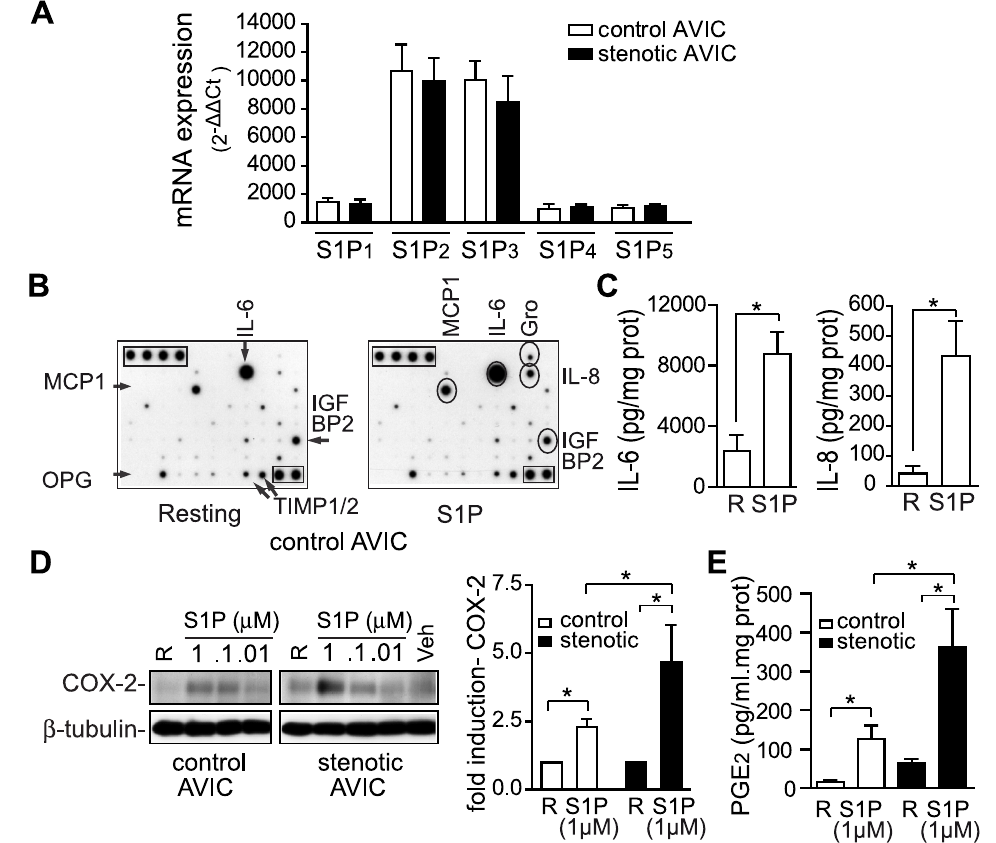
Figure 1. S1P induces pro-inflammatory molecules in AVICs. A) S1P receptor expression in control and stenotic AVICs (mean 6 SEM of the relative mRNA levels normalized to b -actin, n=7–10), was assessed by quantitative RT-PCR. B–C) 1 m M S1P induced cytokine secretion, as observed in antibody arrays and ELISA assays (representative of n=4, 12 h). Squares indicate positive controls; arrows, constitutive cytokines; ovals, S1P-induced cytokines. D–E) Comparison of S1P-mediated induction of COX-2 expression (mean 6 SEM, n=8–12, 1 m M S1P) and PGE 2 secretion (mean 6 SEM, n=4–5). ELISA data, expressed as pg, were normalized to the cell protein content (mg). * p , 0.05. White bars indicate control AVIC; black bars, stenotic AVIC. Gro indicates growth-regulated oncogene a , b , and c ; MCP-1, monocyte chemotactic protein-1; R,